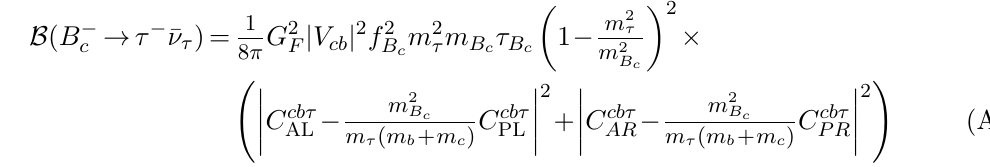
Figure 6 . The Br( B c ! (cid:28) (cid:23) (cid:28) ) as a function of C (cid:28) this branching fraction from [53] and [54] respectively are also shown. The SM branching ratio